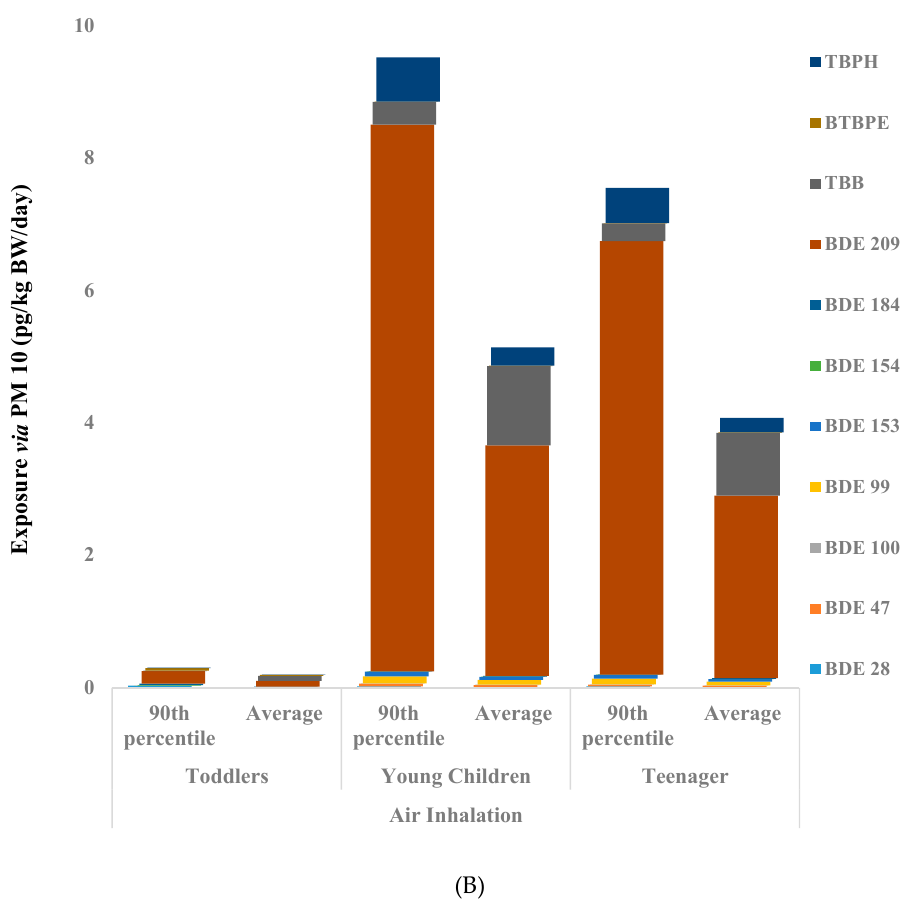
Figure 4. ( A ) Estimated daily exposure (ng/kg/bw/day) to BFRs via dust ingestion for Saudi young children from their rooms. (B ) Estimated daily exposure (pg/kg/bw/day) to BFRs PM 10 inhalation for Saudi young children from their